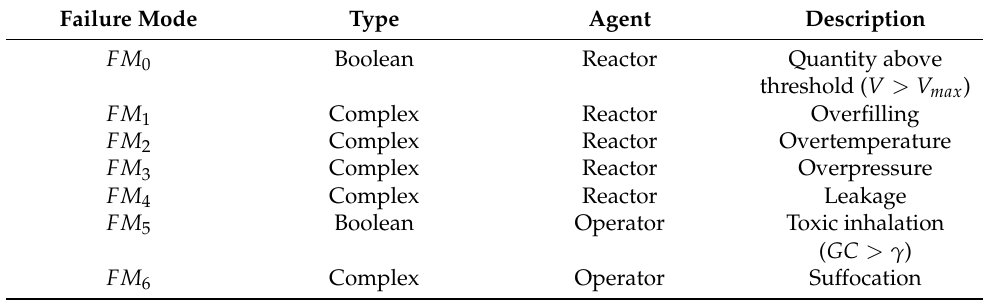
Table 3. Agents failure